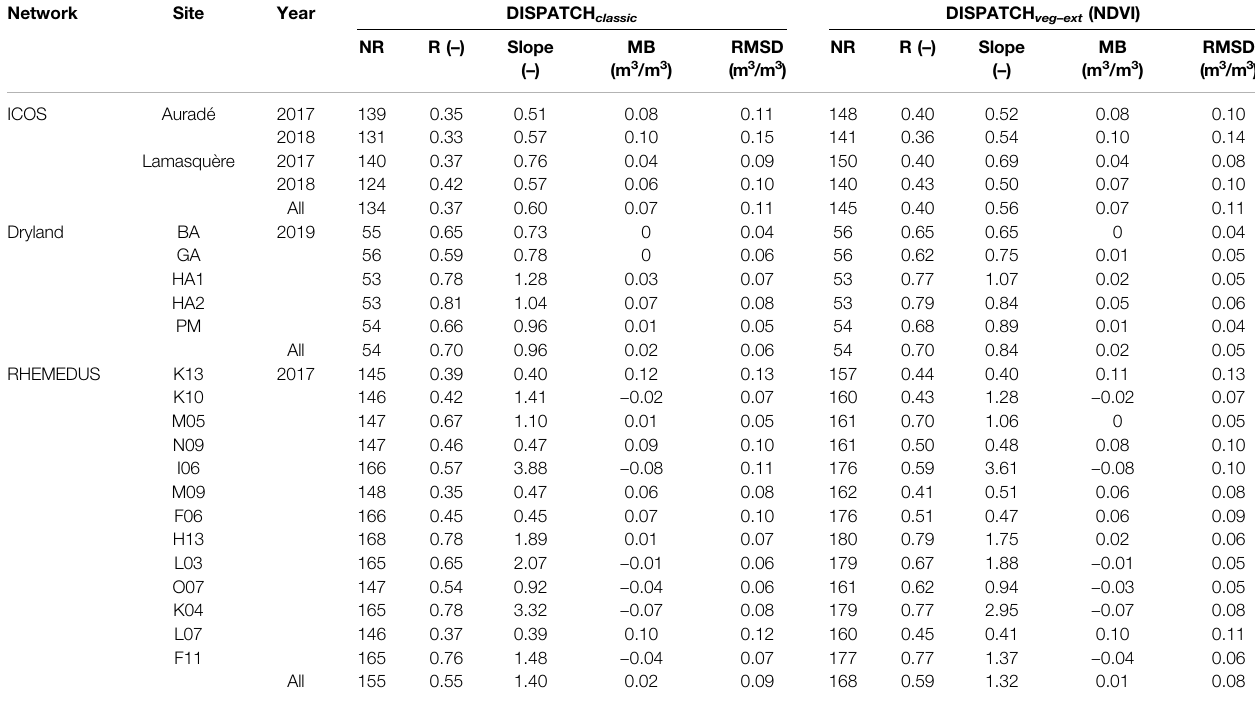
TABLE 2 | Statistical results in terms of correlation (R), slope of the linear regression (Slope), mean bias (MB), RMSD between 1 km resolution disaggregated and in situ SM for (NDVI-based) DISPATCH classic and DISPATCH veg – ext